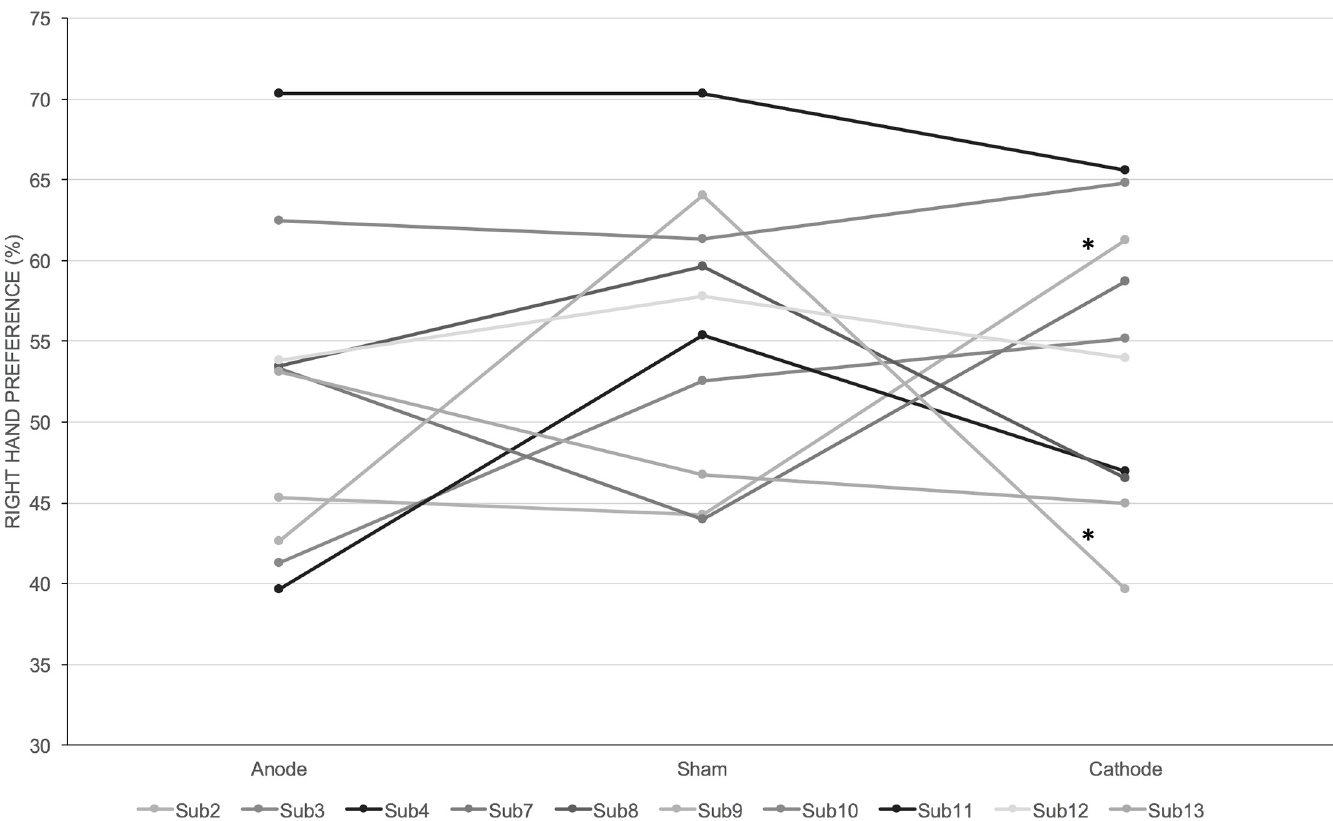
Fig 4. Right-hand preference in free-choice trials. Shows the right-hand preference in free-choice trials expressed as percentage for individual subjects during the different stimulation conditions. Only 2 out of 10 subjects showed significant difference in the hand preference during real vs sham stimulation (indicated by